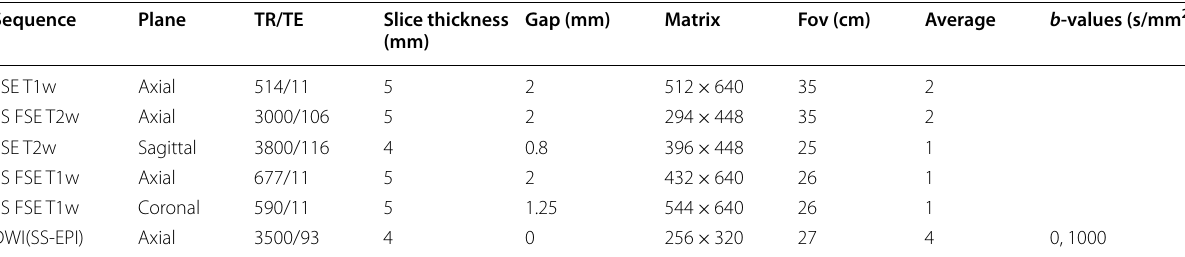
Fig. 1 Flowchart of patient inclusion and exclusion. NAT neoadjuvant therapy followed by radical hysterectomy; CCRT, concurrent